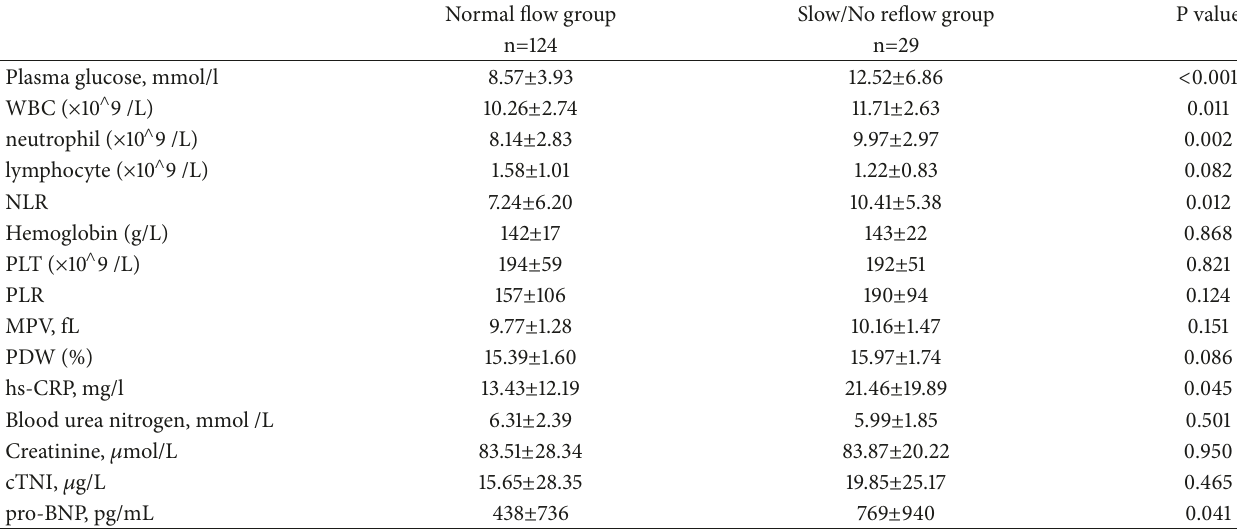
Table 2: Preoperative laboratory data of patients.